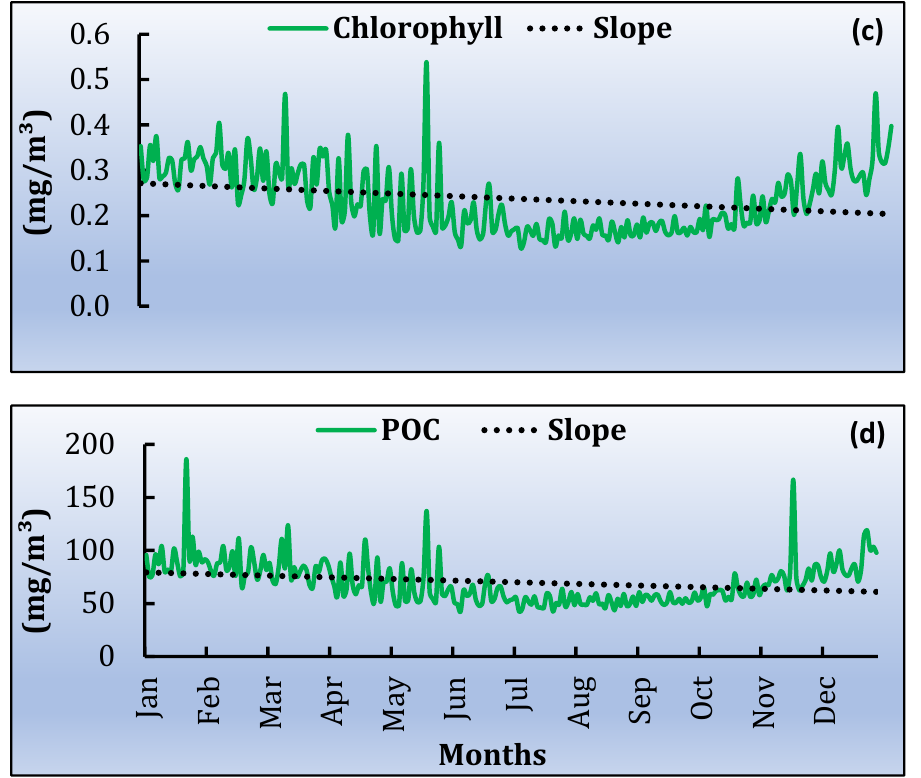
Figure 7. Variability of satellite products monthly average data (2000–2020) for ( a ) SST daytime, ( b ) SST night-time, ( c ) Chl-a concentration and ( d ) POC concentration.